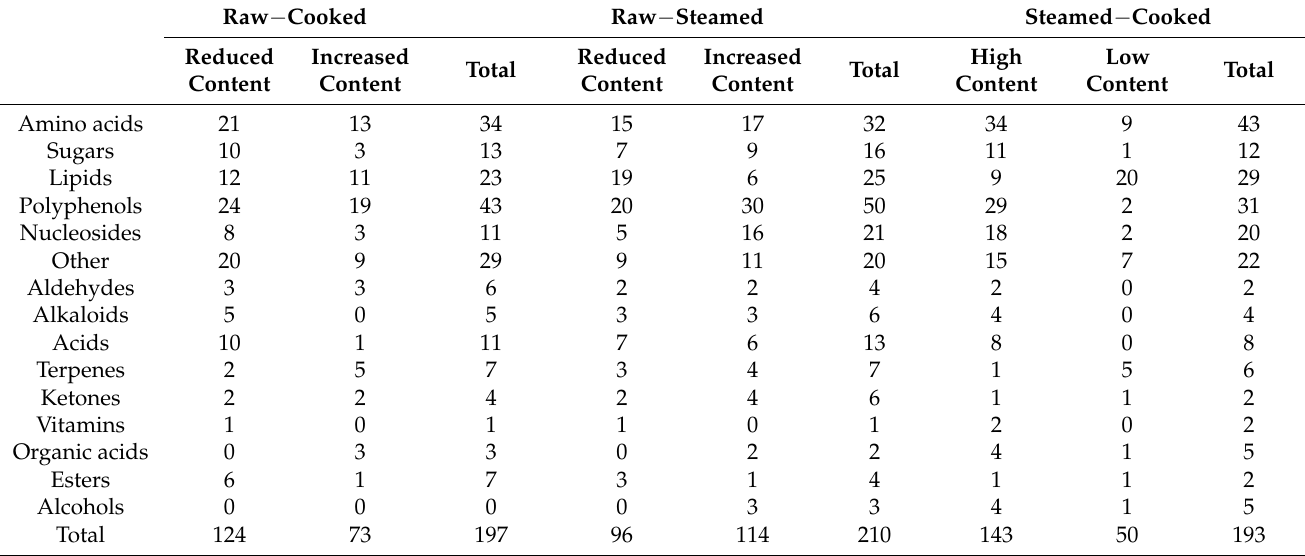
Table 1. Comparison of differential metabolite